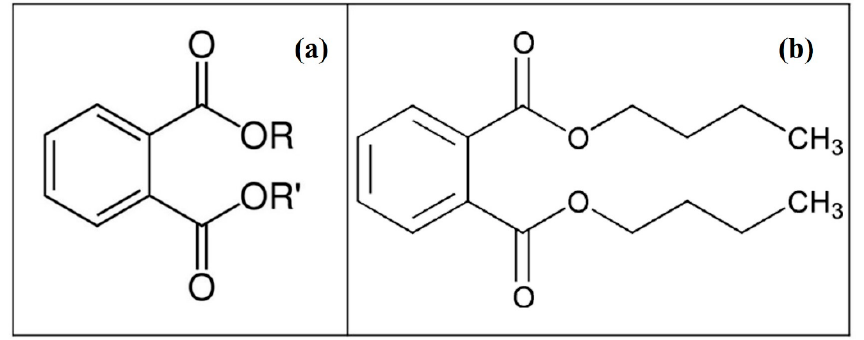
Figure 1. Chemical structure of ( a ) phthalate esters (PAEs) and ( b ) di- n -butyl phthalate (DBP).